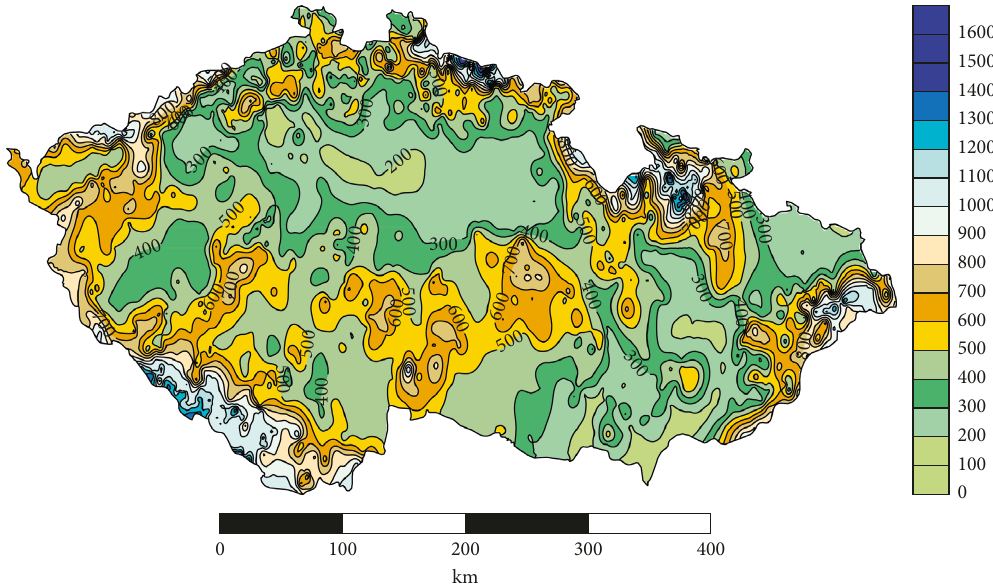
Figure 5: Elevation generated from the gathered control